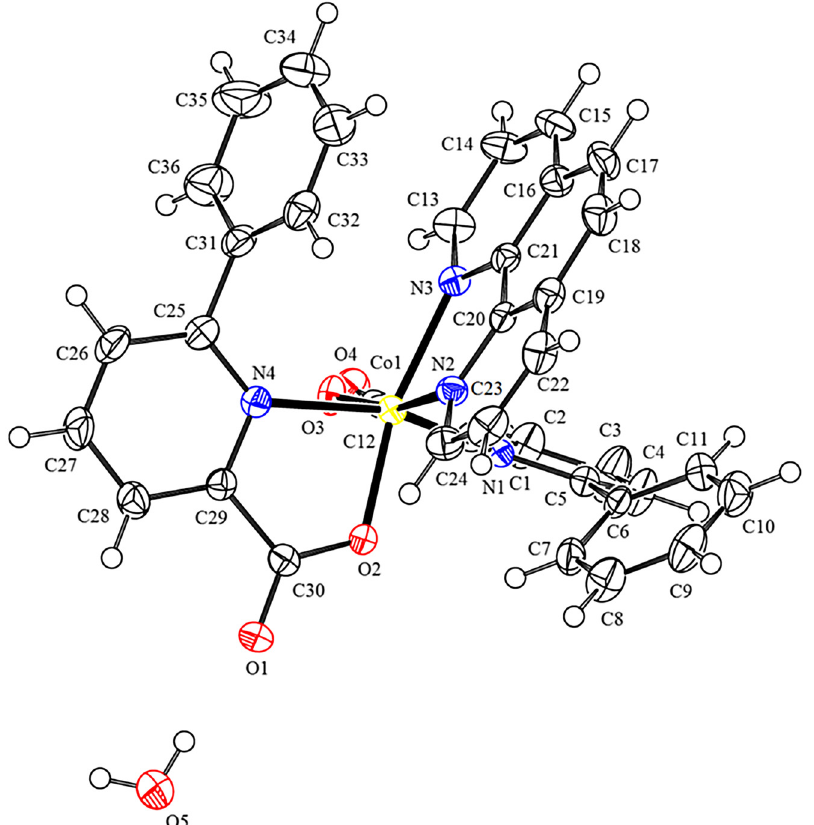
Table 1 contains crystallographic data and Table 2 contains the list of the atoms including atomic coordinates and displacement parameters.